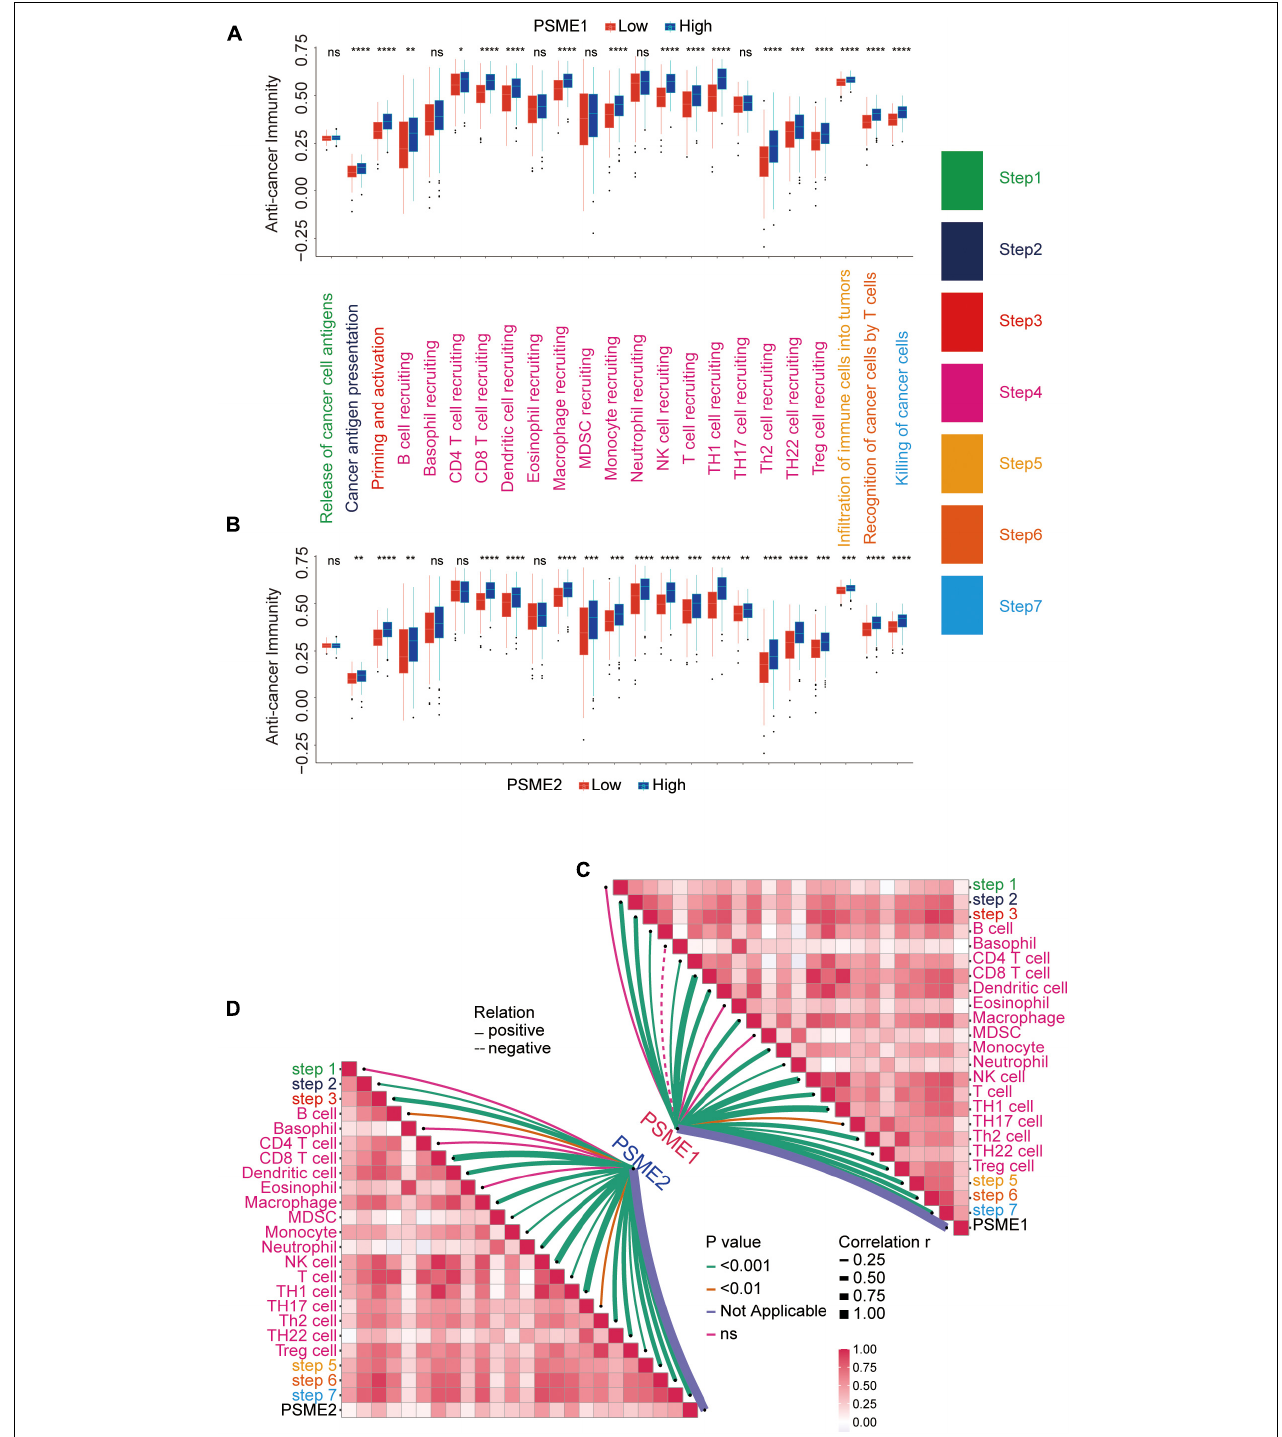
FIGURE 12 | The relationship between PSME genes and anti-cancer immunity cycle. (A) Differences in the multiple steps of the anti-cancer immunity cycle in high and low PSME1 groups in GC. (B) Differences in the multiple steps of the anti-cancer immunity cycle in high and low PSME2 groups in GC. (C) Correlation between PSME1 and the steps of the anti-cancer immunity cycle. (D) Correlation between PSME1 and the steps of the anti-cancer immunity cycle. * p < 0.05; ** p < 0.01; *** p < 0.001; and **** p < 0.0001.